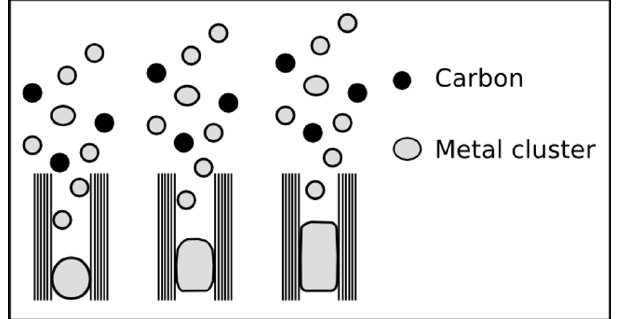
Figure 13. Open tip base growth: The filling of the cavity results from the diffusion of small metal clusters that are produced in the gas phase. The clusters diffuse a certain distance, eventually forming a continuous